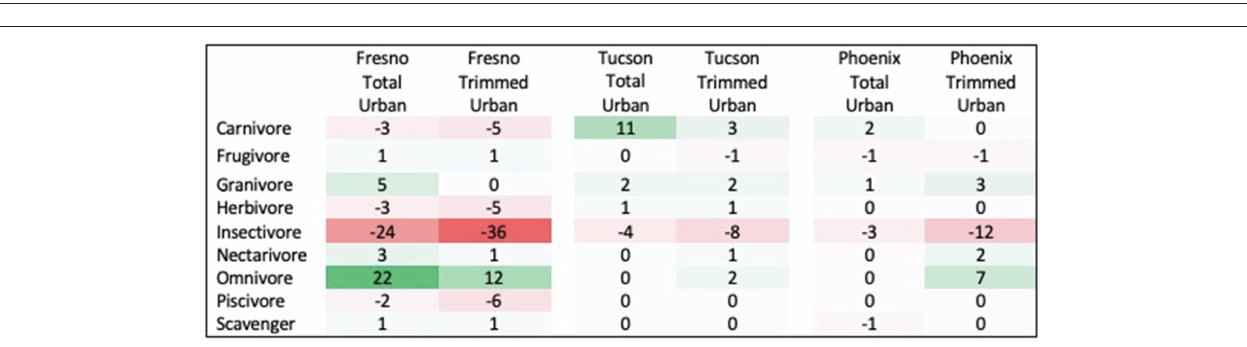
FIGURE 2 | Percent change in prevalence of each diet guild in winter urban species assemblages compared to winter regional species pool. Guilds that are over-represented in urban species assemblages are shaded in green, while guilds that are under-represented in urban species assemblages are shaded in red.